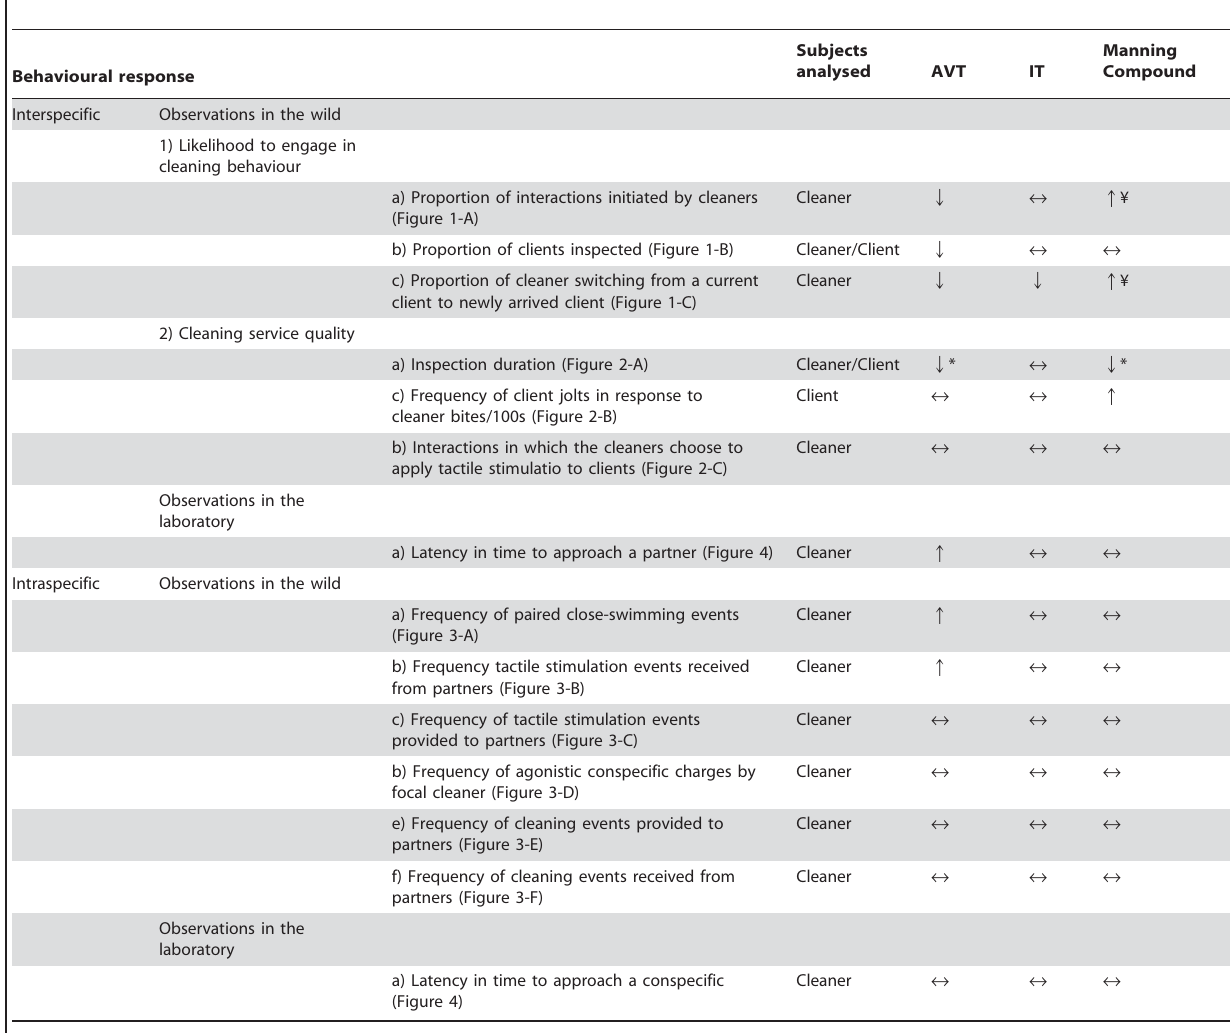
Table 1. Manipulations of arginine vasotocin (AVT), isotocin (IT) and manning compound injected into the cleaner fish Labroides dimidiatus compared with saline